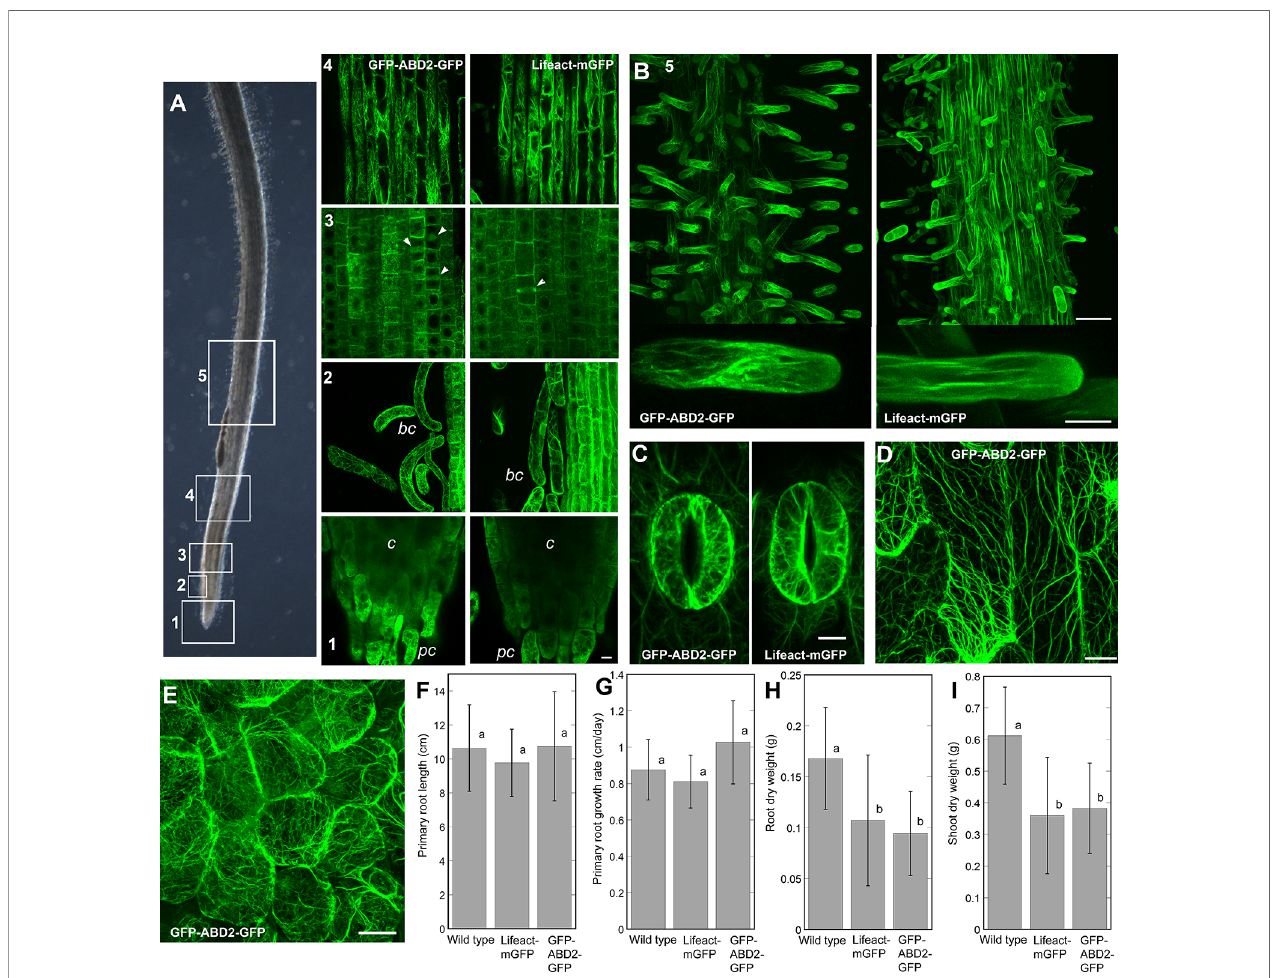
FIGURE 3 | Representative images of F-actin in various cells and tissues of M. truncatula seedlings expressing the UBQ10:GFP-ABD2-GFP and UBQ10:Lifeact- mGFP reporters. (A) F-actin in various developmental regions of seedling primary roots. Numbers (1-5) in (A , B) correspond to regions of the bright fi eld image of the root shown in (panel A ). 1 = root cap, 2 = border cells, 3 = meristem 4 = elongation zone, 5 = root hairs. Note that while peripheral cap ( pc ) and border cells ( bc ) have distinct F-actin arrays, the columella ( c ) region has diffuse fl uorescent signal. Arrowheads in the root meristem mark the phragmoplasts. (B) Both UBQ10:GFP- ABD2-GFP and UBQ10:Lifeact-mGFP decorate F-actin in growing root hairs. Extensive F-actin networks were also documented in guard cells of cotyledons (C) , epidermal cells of minor veins of a young leaf (D) and epidermal cells in a young nodule (E) . Scale bars = 10 µm (for A , C , D ) 20 µm (for E ), 50 µm (for low magni fi cation images in B ) and 10 µm (for high magni fi cation images in B ). Primary root length and primary root growth rate were not affected in UBQ10:GFP-ABD2- GFP and UBQ10:Lifeact-mGFP lines, compared to wild type (F , G) . Actin reporter lines showed smaller root and shoot dry weight when compared to wild type, after 28 days of growth (H , I) . Statistical signi fi cance was determined by one-way ANOVA. Bars are means (n > 16 plants) ± S.E. Different letters indicate signi fi cant differences among means (P < 0.05, Tukey ’ s